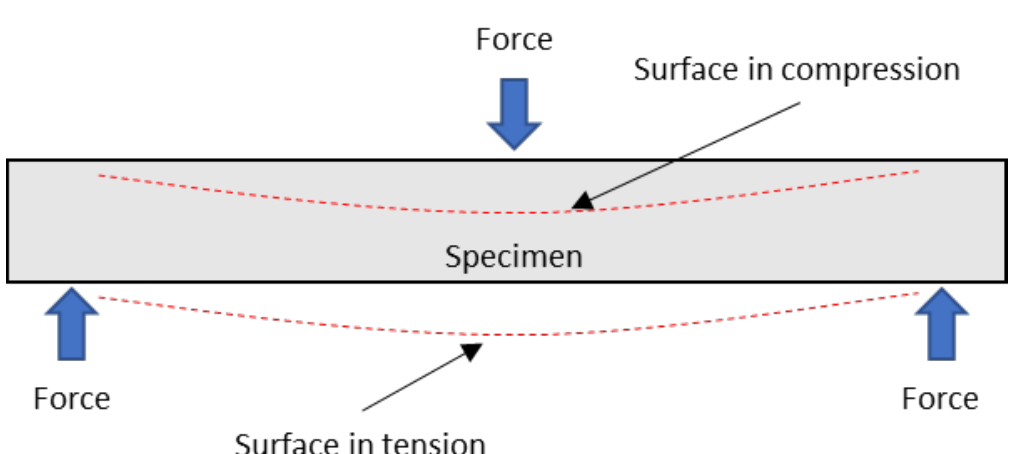
Figure 8. Compression and tensile force combination during the flexural test.